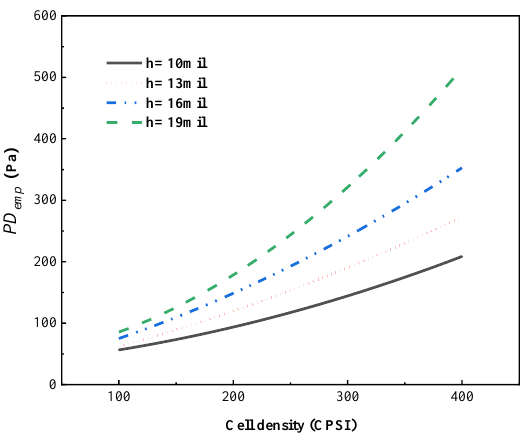
Fig. 10. Influence of the substrate cell density and wall thickness on the DPF no-load pressure drop under certain conditions (Apparent volume of the filter: 10L; Length-to- diameter ratio: 1.03; Initial porosity of the filter wall: 0.55; Initial mean pore diameter of the filter: 10 μm ; The inlet gas temperature: 250 ℃ ; Gas volume flow: